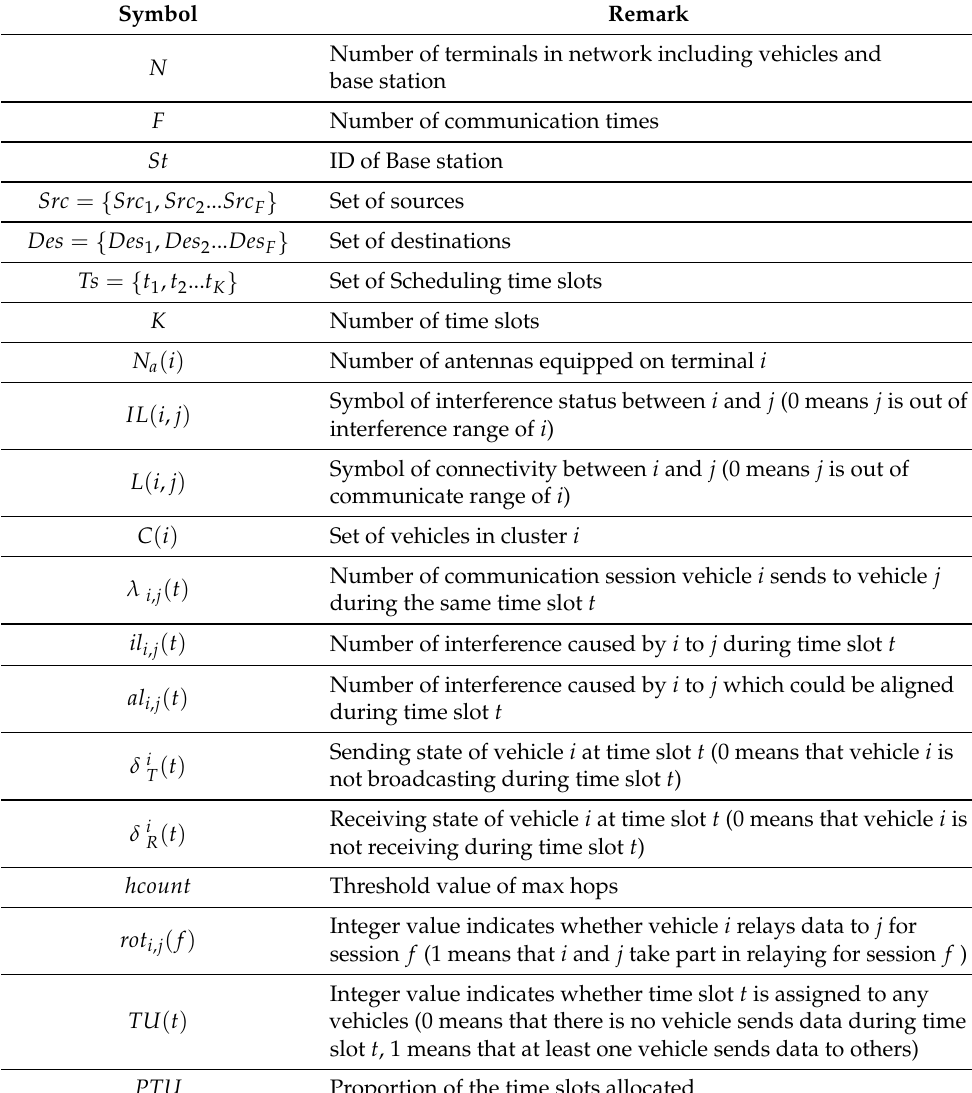
Table 1. SYMBOLS and